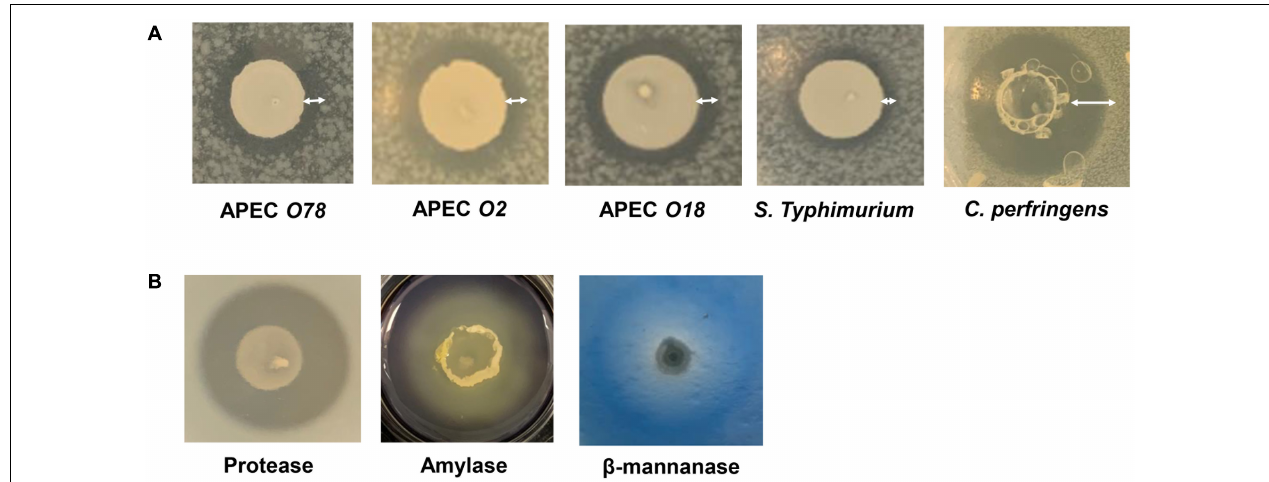
FIGURE 1 | Screening of Bacillus spp. DFM candidates for pathogen growth inhibition and enzyme activities. (A) Microorganism growth inhibition. Representative examples of microorganism overlay assays were presented with the following microorganisms, Avian Pathogenic Escherichia coli serotype O78, O2, and O18, Salmonella enterica serovar Typhimurium ATCC 14028, and Clostridium perfringens NAH 1314-JP1011. Overlay microorganism inhibition assays were performed in duplicate for each of the Bacillus spp. strains. A zone of inhibition was measured from the edge of Bacillus spp. until the end of clearance zone as shown as white double-edge arrows. (B) Screening of digestive enzyme activities of Bacillus spp. strains. The assay was performed in duplicate for each Bacillus spp.